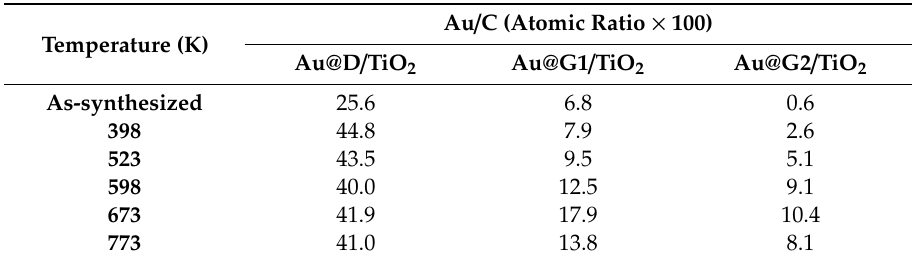
Table 2. XPS results of the annealing treatments under ultra-high vacuum (UHV) at the indicated